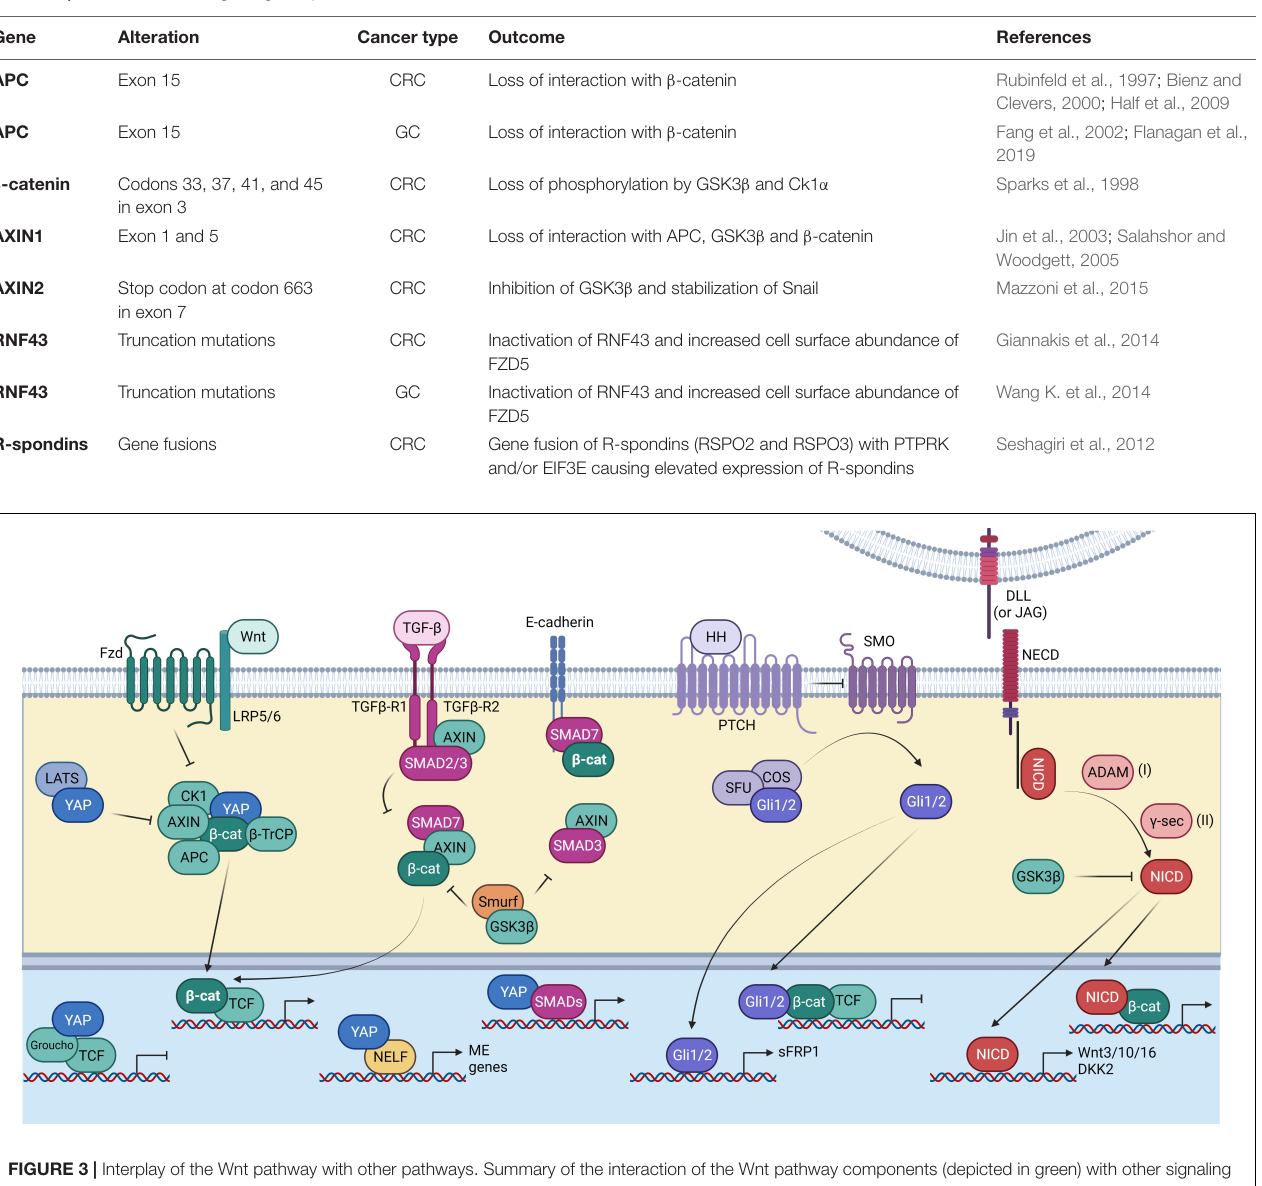
TABLE 1 | Mutations in Wnt signaling components in cancers.